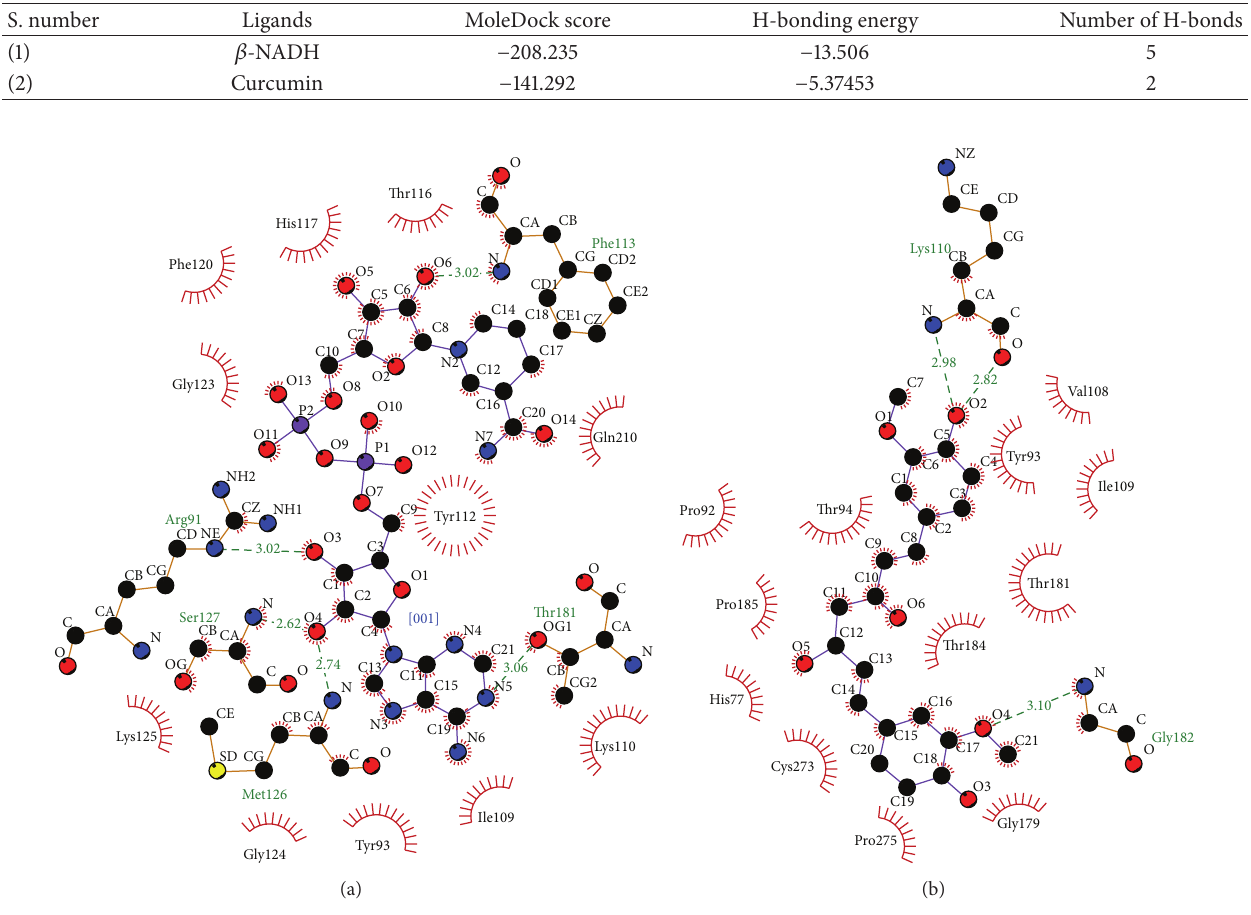
Figure 5: (a, b) Docked conformation of hydrogen bonding view and hydrophobic interaction of (a) 𝛽 -NADH and (b) curcumin with amino acids of human NADH-cytochrome 𝑏 5 reductase protein (PDB: 1 umk.pdb) at the active site cavity (hydrogen bonds as green dashed lines between the atoms involved and hydrophobic contacts as an arc with spokes radiating towards the ligand atoms).